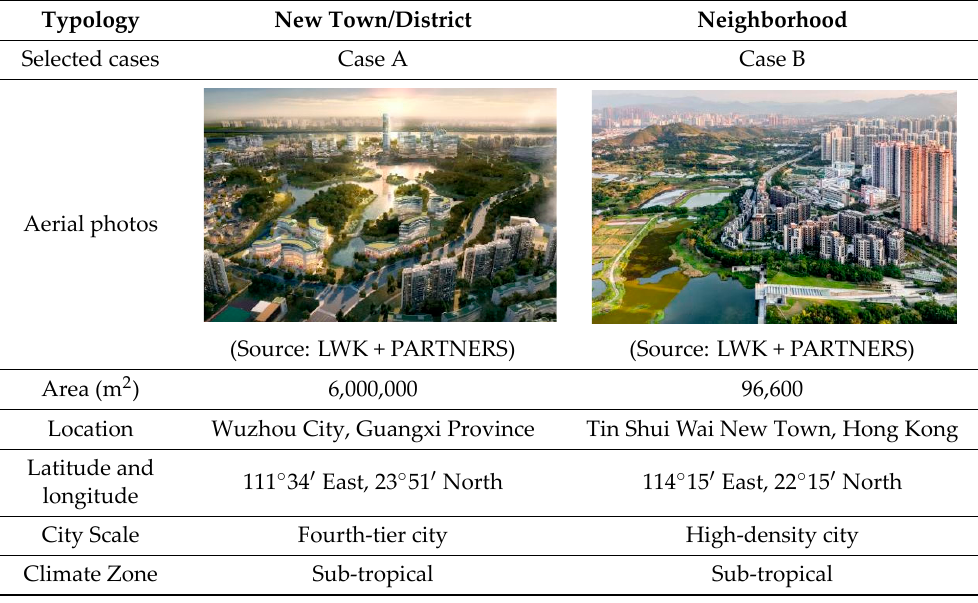
Table 10. Basic information for the studied cases.